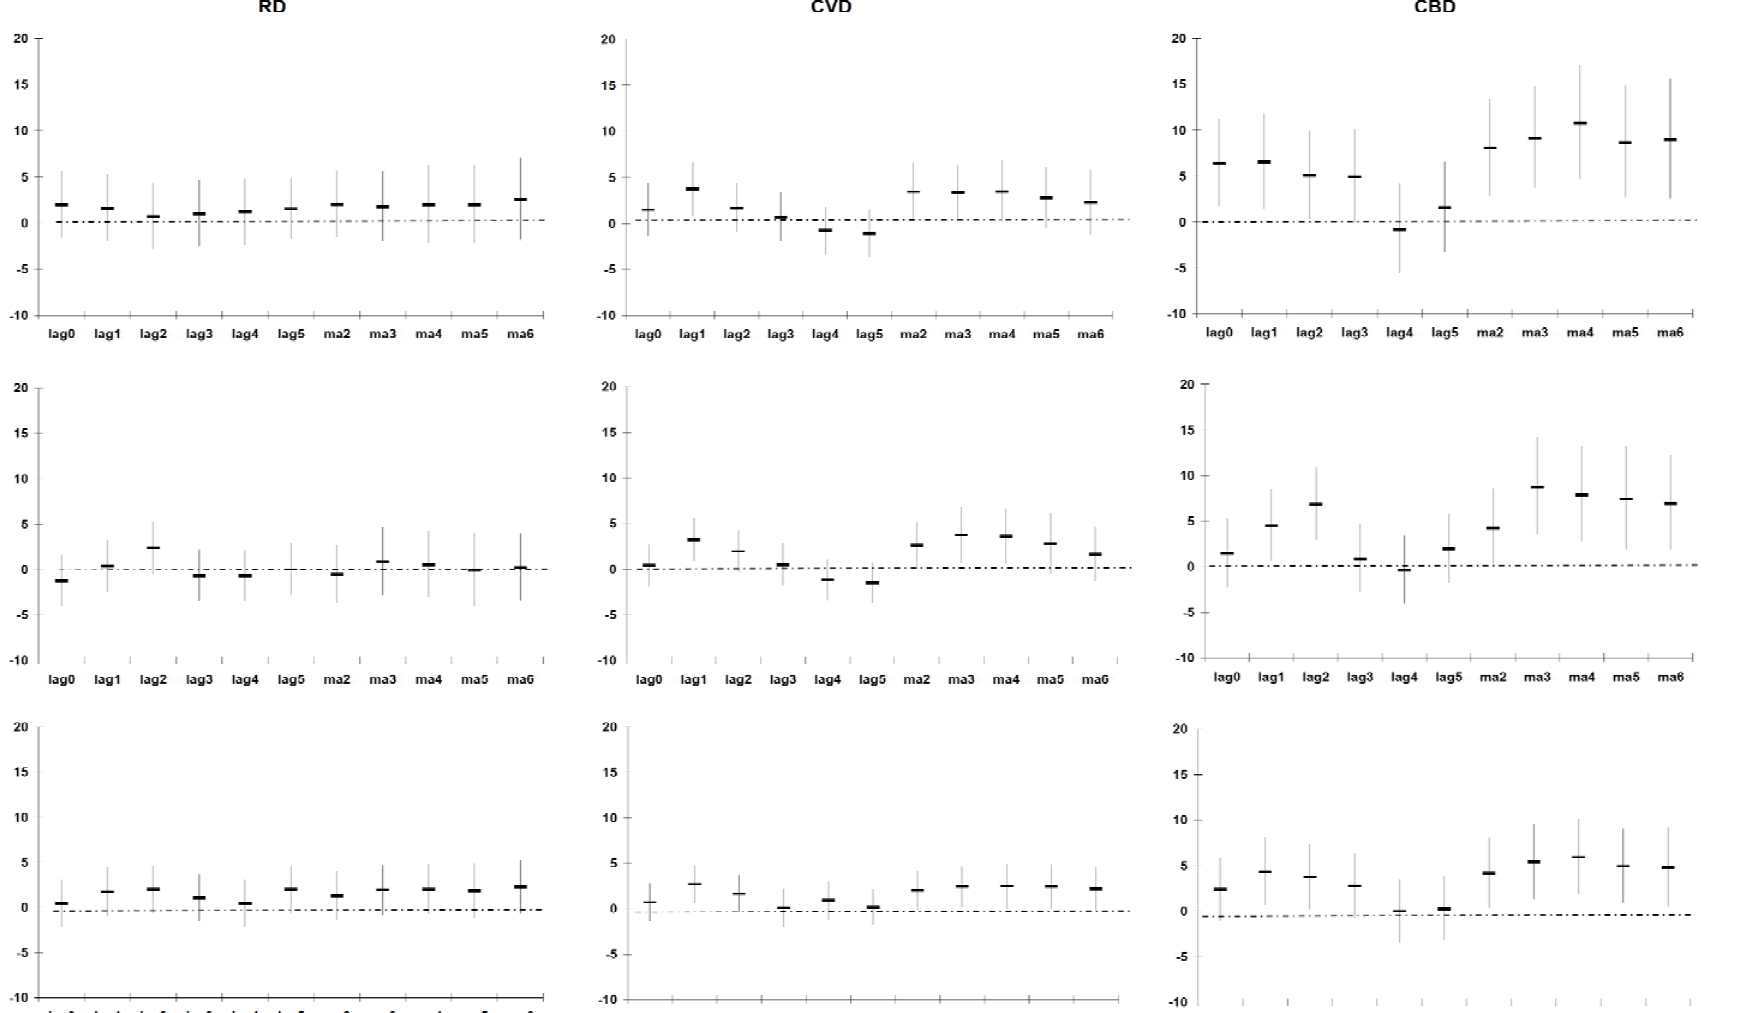
Figure A5. Percentage change (95% CI) in cause-specific mortality in Cape Town per inter-quartile range increase in PM during 2001–2006 (entire year), adjusted for Tapp, rainfall, wind speed and public